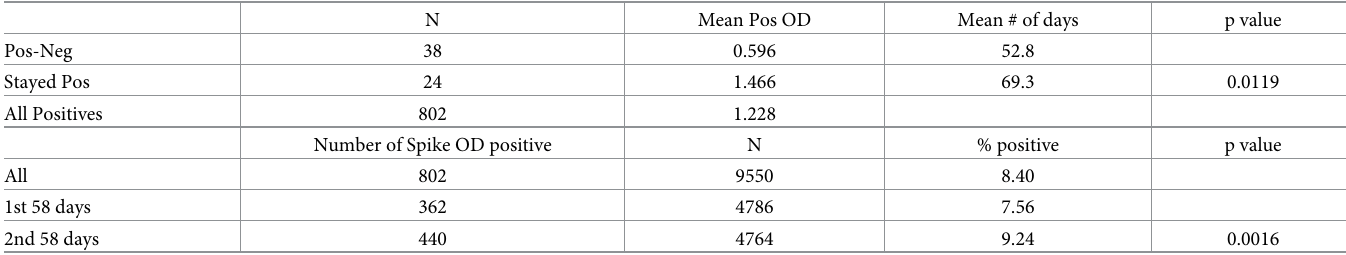
Table 3. Assessment of raw S protein OD values in donors with 2 or more donations analyzed over 2 time periods from August 13th to December 8th of 2020.